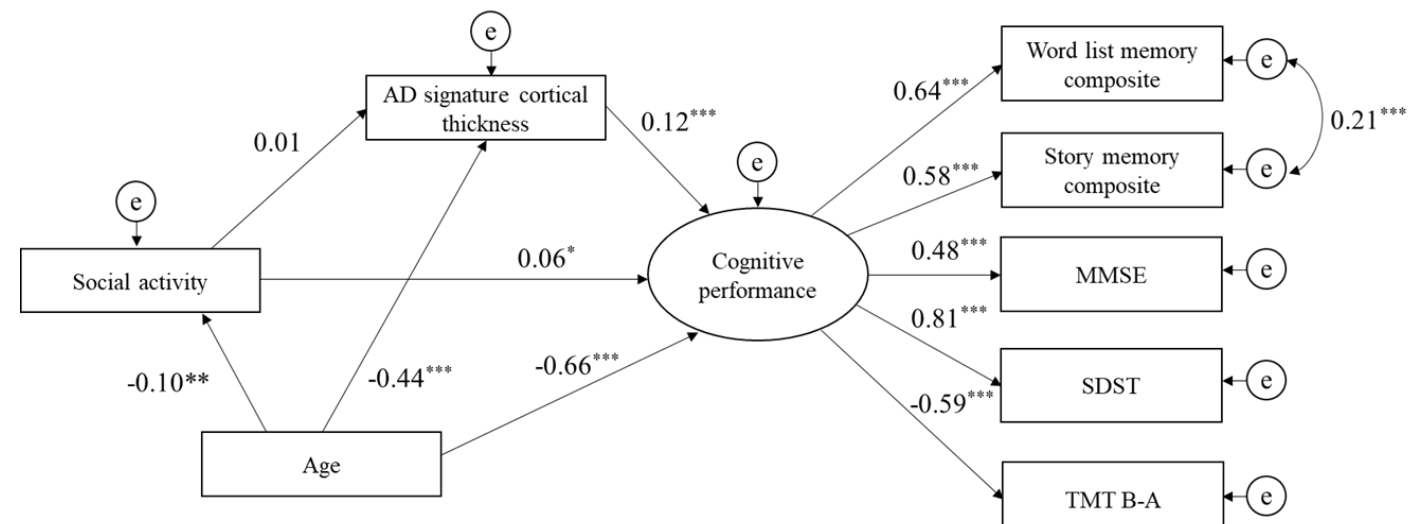
Figure 3. Structural model for associations of social activity, AD signature cortical thickness, and cognitive performance. Goodness of fit index = 0.98, comparative fit index = 0.97, root mean square error of approximation = 0.06. e, error term; MMSE, Mini-Mental State Examination; SDST, Symbol Digit Substitution Test; TMT B-A, Trail Making Test part B minus part A. * p < 0.05, ** p < 0.01, *** p < 0.001.